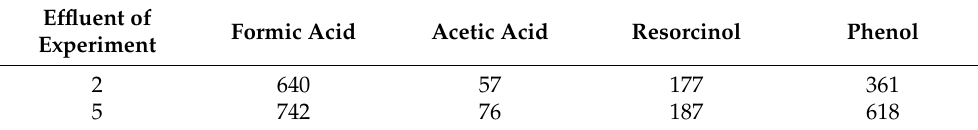
Table 4. Organics in reactor effluents of the experiments with Reed Canary Grass (in mg L − 1 ). Effluent